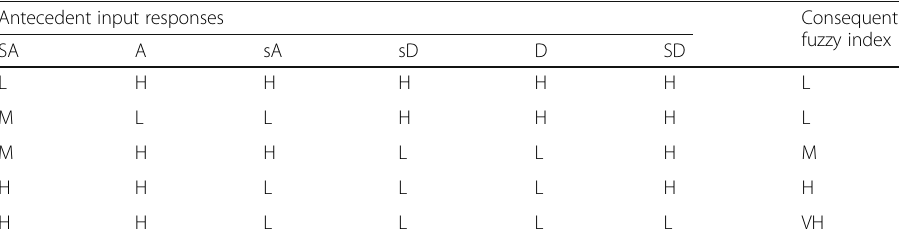
Table 2 Representative five rules from the rule-base containing 144 rules, symbols have their usual meanings as (L: Low, M: Medium, H: High, VH: Very